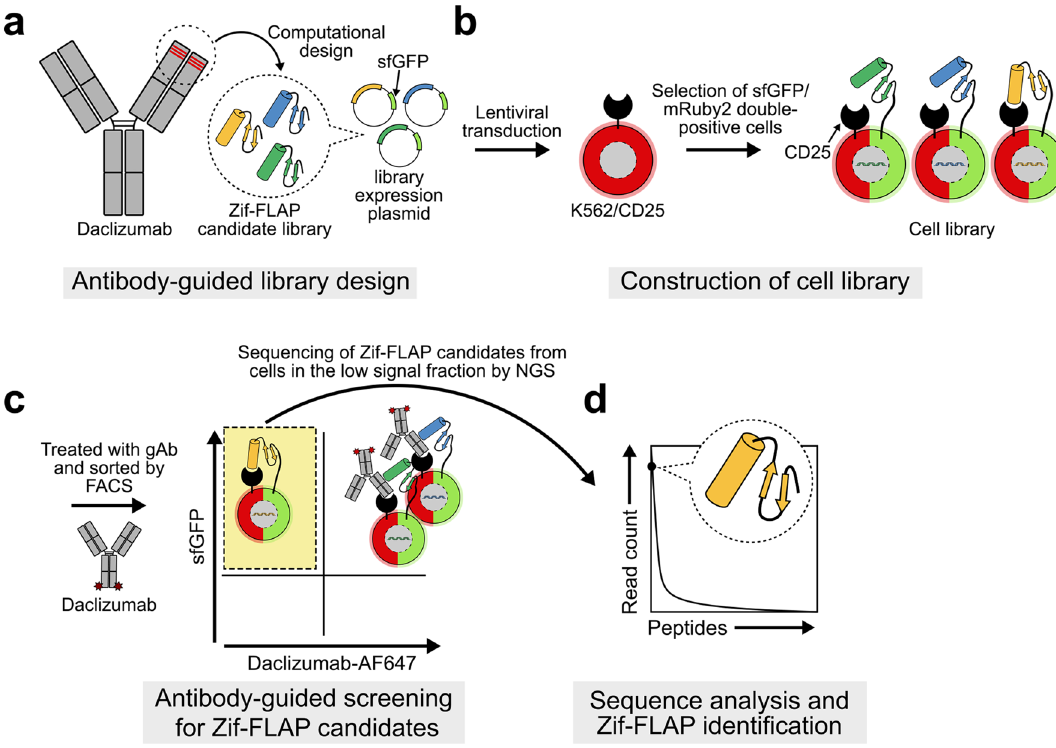
Figure 1. Overview of the MAGPIE system. ( a ) Computational design of the peptide library using the anti-CD25 mAb daclizumab as a guide and construction of the plasmid that expressed the Zif-FLAP candidate library. ( b ) Construction of the cell library by lentiviral transduction of K562/CD25 cells with vectors that coordinately expressed Zif-FLAP candidates and sfGFP. Linking the expression of CD25 and Zif-FLAP candidates on the cell surface with coexpression of mRuby2 and sfGFP in the cytosol, respectively, allowed visual tracking of library cells. ( c ) Antibody-guided screening of Zif-FLAP candidates using fluorescently labeled daclizumab (daclizumab-AF647). Isolation of the low signal fraction that included cells expressing high affinity Zif-FLAP candidates after incubation with daclizumab-AF647. ( d ) NGS analysis of CD25-binding sequences of the isolated Zif-FLAP candidates and identification of